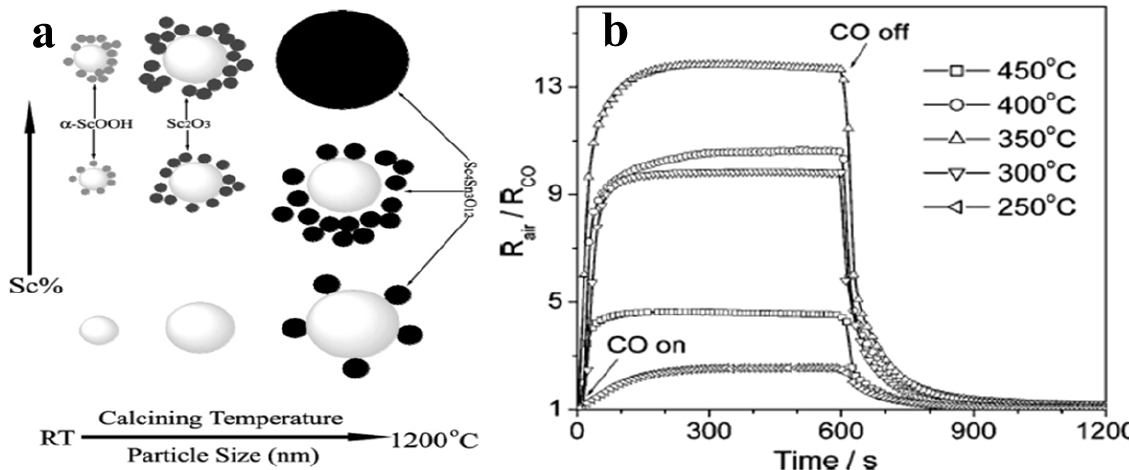
Figure 9. ( a ) Phasic dependence of the (SnO 2 ) 1 − X (Sc 2 O 3 ) X (X = 0.002–0.6) nanocrystallites upon the calcination temperature/particle size; ( b ) effect of operation temperature on the sensitivity of CO in 1000 ppm of the as-sintered (SnO 2 ) 0.90 (Sc 2 O 3 ) 0.10 pellet. (Reprinted with permission from [74]. Copyright 2005, American Chemical Society, Washington, DC, USA).